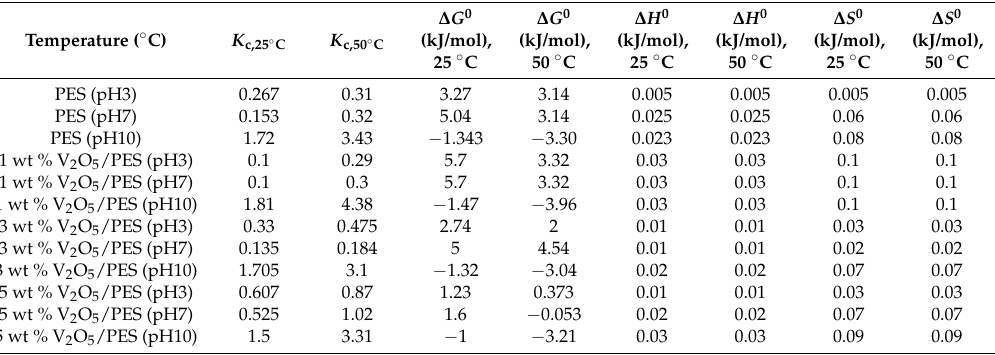
Thermodynamic parameters for the adsorption of methylene blue (MB) onto the polyethersulfone (PES) electrospun nanofibrous adsorbents (ENAs).